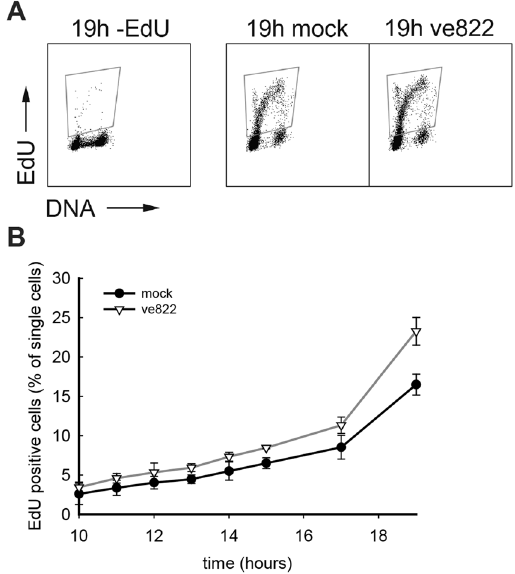
Figure 5. Importance of ATR in RPE cells in G1. Analysis of EdU incorporation in RPE cells synchronized in G0, released into the cell cycle and treated with ATR inhibitor in G1. ( A ) Dot plots showing DNA content versus EdU intensity in individual RPE cells 19 hours after release from G0. Gating for EdU-positive cells was determined based on the control without EdU. ATRi ve822 160 nM was added at the time of release from G0 arrest. ( B ) Quantification of EdU-positive RPE cells at the indicated time points of cells treated with 160 nM ve822 ( ∇ ) or mock ( • ) as in A. Each time point was performed in separate barcoding sets including a sample from exponentially growing cells not given EdU (-EdU control). Error bars show standard deviations calculated from 3 independent